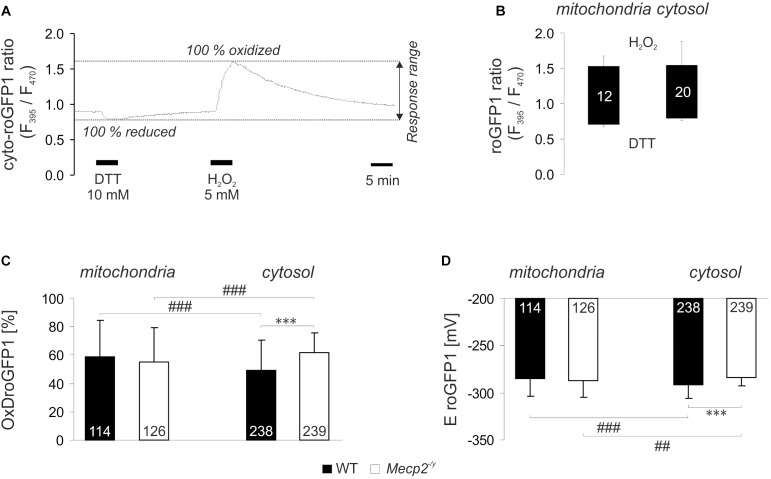
Reduction-oxidation sensitive green fluorescent protein 1 (roGFP1) response calibration reveals genotypic and compartmental redox differences at baseline resting conditions. (A) Dynamic response of cyto-roGFP1 to saturating oxidation and reduction, as recorded from a WT slice culture. (B) The box plot summarizes the response ranges of mito-roGFP1 and cyto-roGFP1 determined during the calibration experiments. The bottom of each box represents the fully reduced state evoked by 10 mM DTT, the ceiling indicates the fully oxidized level induced by 5 mM H2O2. Error bars in this and all other figures are standard deviations; the number of cells analyzed is reported for each bar. The similarity of the determined response ranges confirms that roGFP reliably functions in both, cytosol and mitochondrial matrix. (C) OxDroGFP1 confirms more oxidized baseline conditions in the cytosol of Mecp2-/y hippocampal neurons than in WT neurons. Mitochondrial redox baselines did not differ among genotypes. Statistically significant differences between WT and Mecp2-/y neurons are indicated by asterisks (∗∗∗p < 0.001). Genotype-matched differences among mitochondria and cytosol are indicated by crosshatches (###p < 0.001). Pairwise comparisons were run as unpaired two-tailed t-tests; the number of cells studied is included in each bar. (D) These genotypic and compartmental redox differences are also evident from the calculated roGFP1 reduction potentials (EroGFP1; ##p < 0.01).